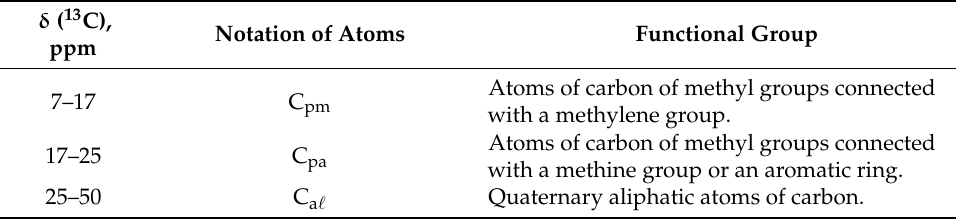
Table 4. Variation limits and interpretation of chemical shifts of 13 C nuclei. δ ( 13